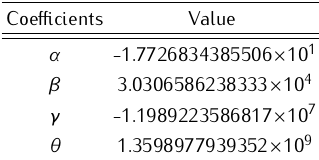
Table 2. Tuned coefficients used in equation 16 to correlate water content as a function of temperature at 2100 kPa